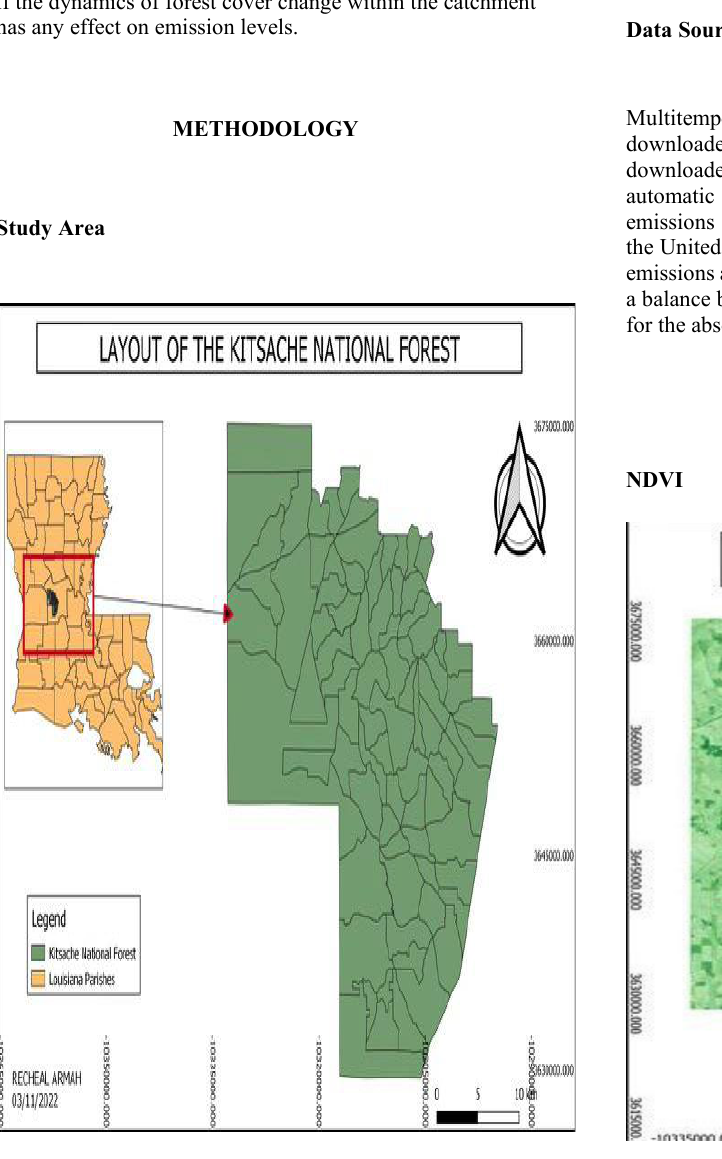
Fig 1: Map of study Kisatchie National